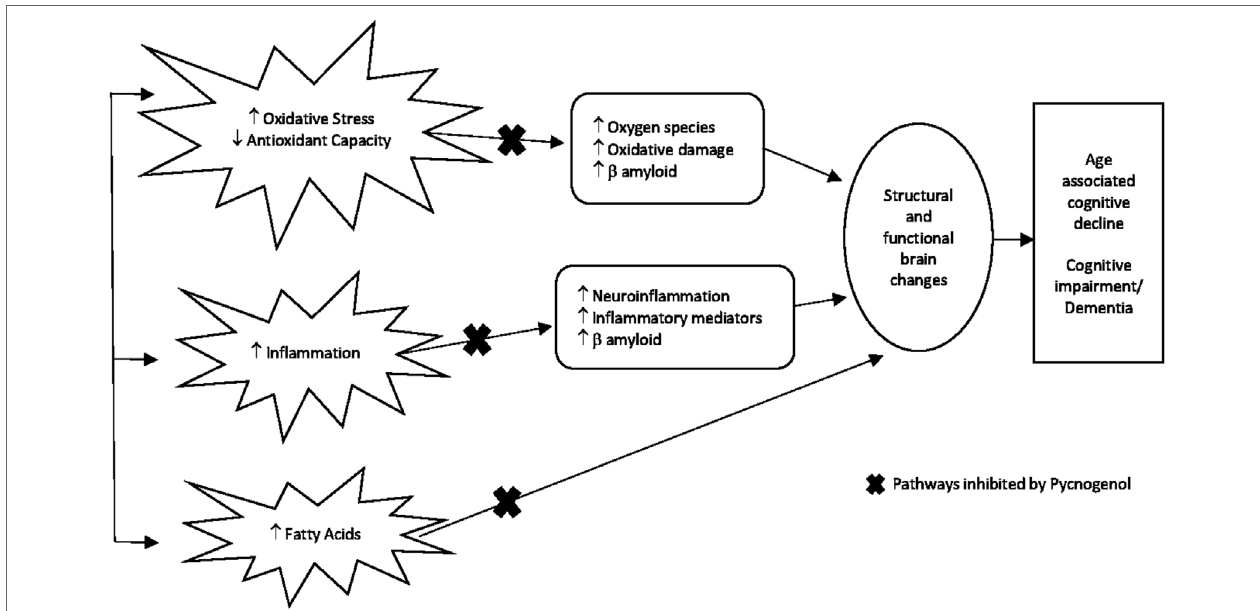
FIGURE 2 | Proposed mechanism of action of PYC as a targeted therapy for preventing cognitive decline. With increasing age, inflammation-reduced antioxidant metabolism leading to increased oxidative stress and damage to fatty acids are common mechanisms that over time can impact on the brain causing structural and functional changes culminating in the outcome of age-associated cognitive decline, cognitive impairment, and/or dementia. PYC potentially inhibits these mechanisms as represented by the x in the diagram due to its scavenging ability to free radicals and protection of proteins (biomolecules) against oxidative damage (Packer et al., 1999; Rohdewald, 2002; Ansari et al., 2008), neuron protection from β amyloid-induced apoptonis (Peng et al., 2002; Gulati, 2014), anti-inflammatory effects (Lau et al., 2004), and reduction of fatty acids (Sivonová et al.,